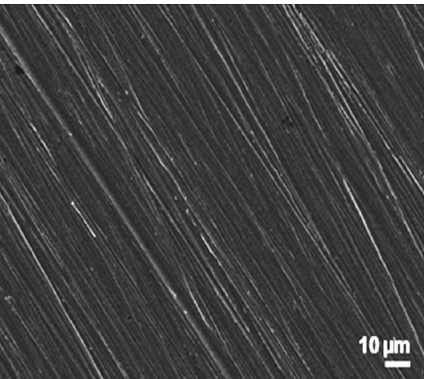
Figure 10: SEM micrograph of carbon steel before the corrosion tests in 1M HCl